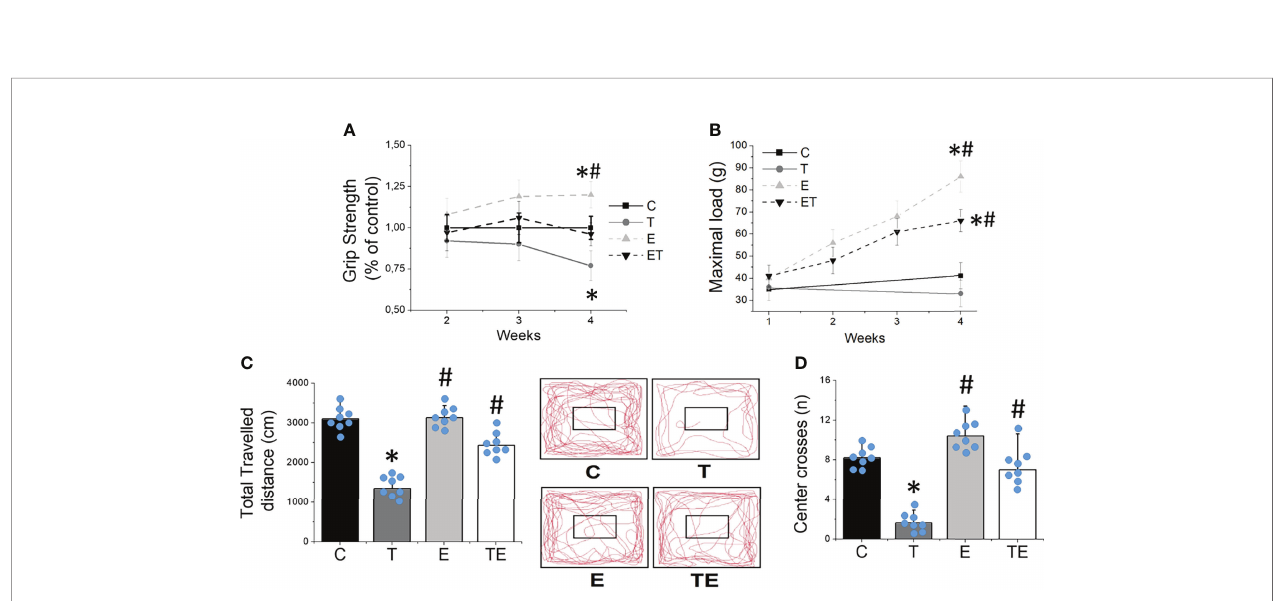
FIGURE 3 | Resistance exercise preclude impaired muscle function provoked by tumor growth. (A) grip strength gain (n = 10) and (B) maximal carrying load (n = 10) over 4 weeks. (C) locomotor/exploratory capacity demonstrated by total travelled distance (n = 8) and (D) number of center crosses (n = 8) in groups control, tumor- bearing, exercised and tumor-bearing exercised. Results are mean ± standard deviation. * p < .05 , compared with control; # p < .05 , compared with Tumor-bearing group (by ANOVA two-way followed by Tukey post-hoc test). C, control group; E, exercised; T, tumor-bearing; TE, tumor-bearing